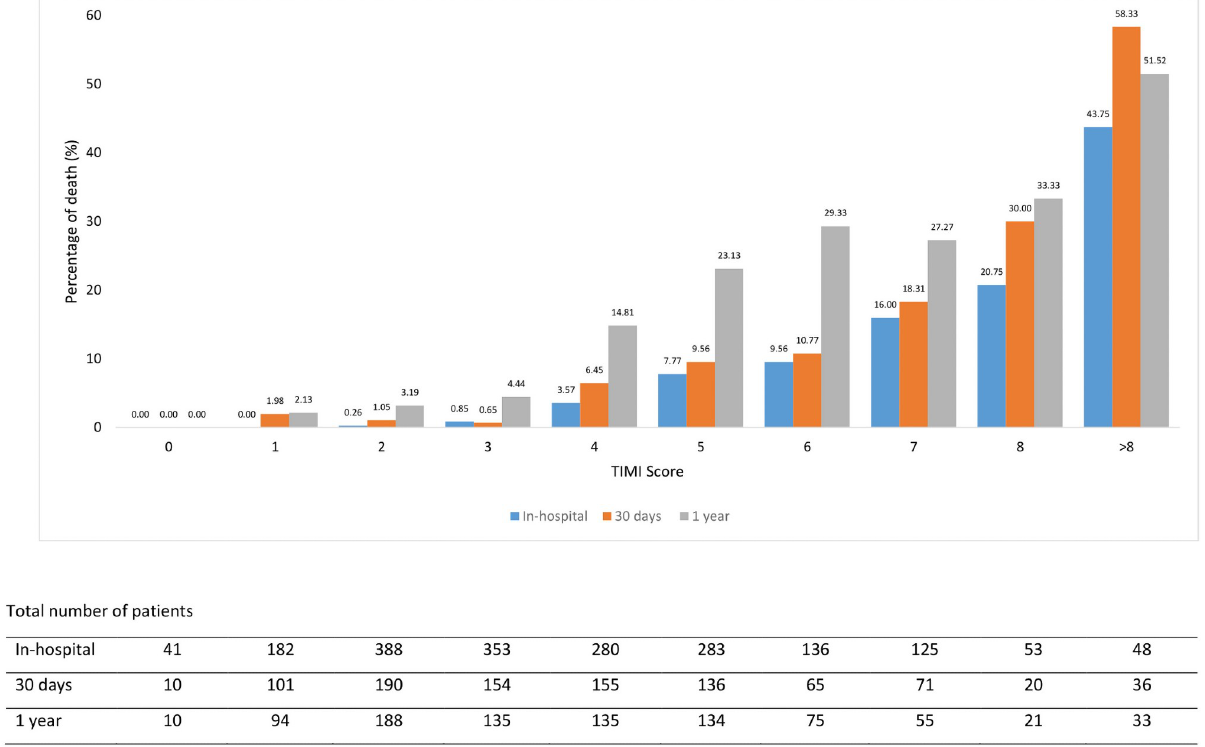
Fig 2. The rate of death across the risk score of